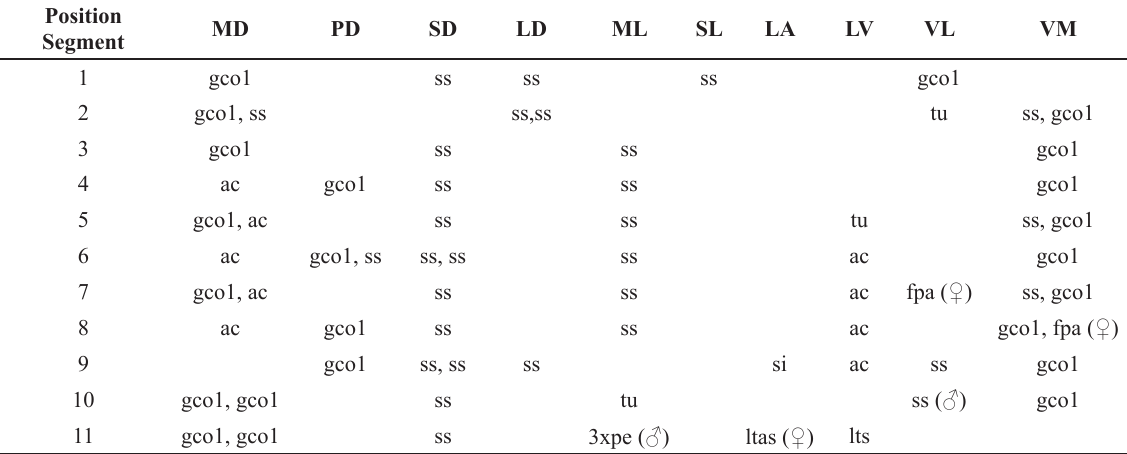
Table 2. Summary of nature and location of sensory spots, glandular cell outlets, tubes and spines arranged by series in Echinoderes aureus Adrianov et al. ,